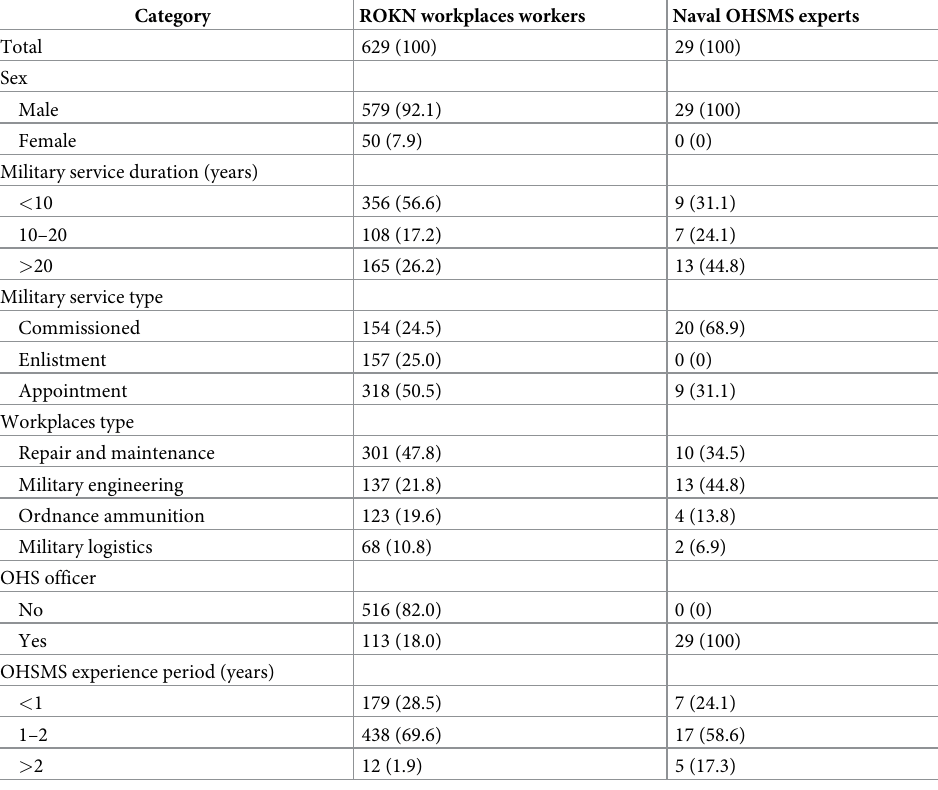
Table 2. Characteristics of the study participants.